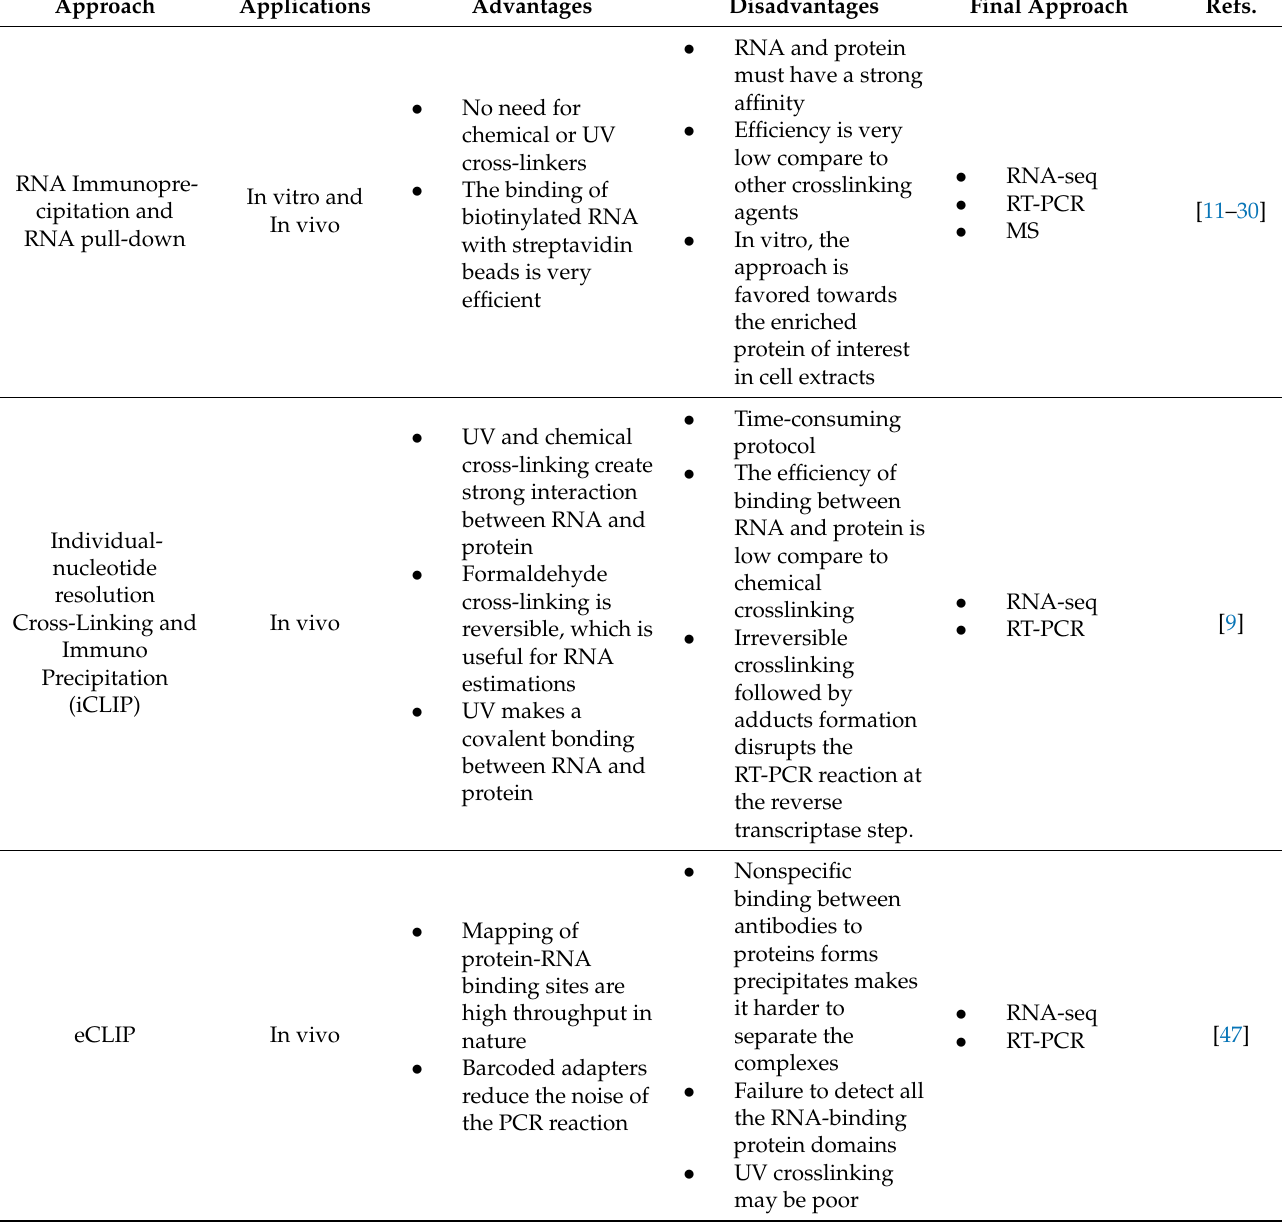
Table 1. Features of selected RNA–protein interaction